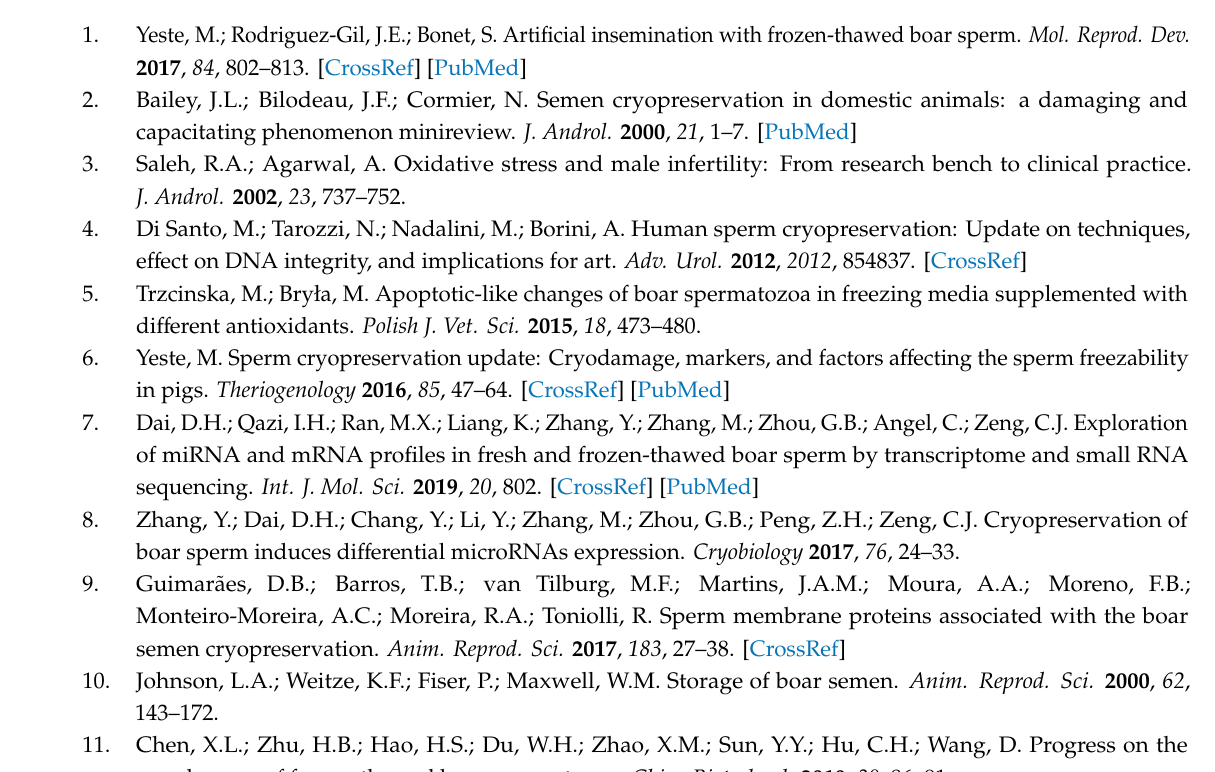
Table S1: All DE miRNAs in giant panda sperm; Table S2: DE miRNAs and their target DE mRNAs in boar and giant panda sperm; Table S3: Apoptosis, glycolysis, and oxidative phosphorylation related DE mRNAs in boar and giant panda